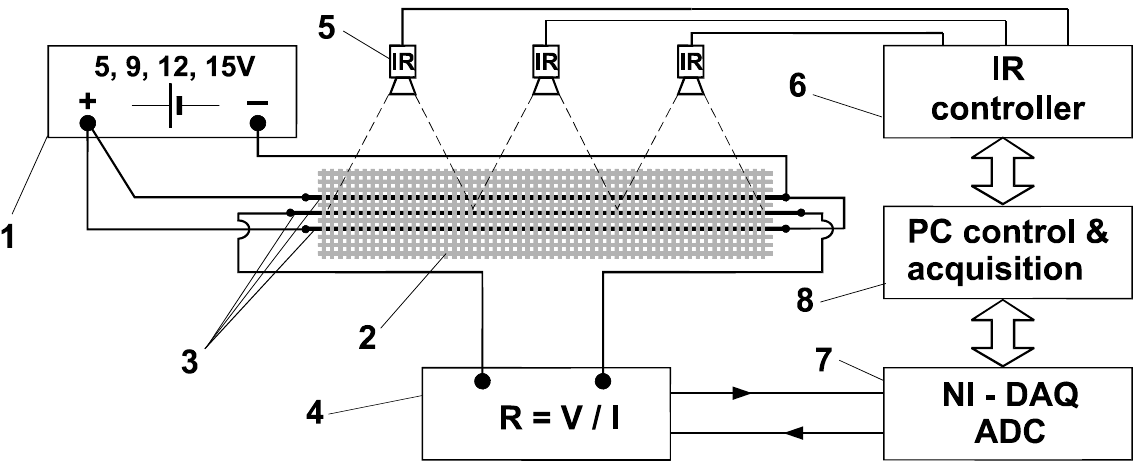
Figure 2. Schematic presentation of connecting sample and measuring system: 1—regulated power supply unit; 2—specimen of fabric; 3—conductive yarns; 4—resistance measuring circuit; 5—IR temperature sensors (MLX90614); 6—microcontroller for powering and acquisition temperature data; 7—NIDAQ converter; 8—personal computer for time control and data acquisition.